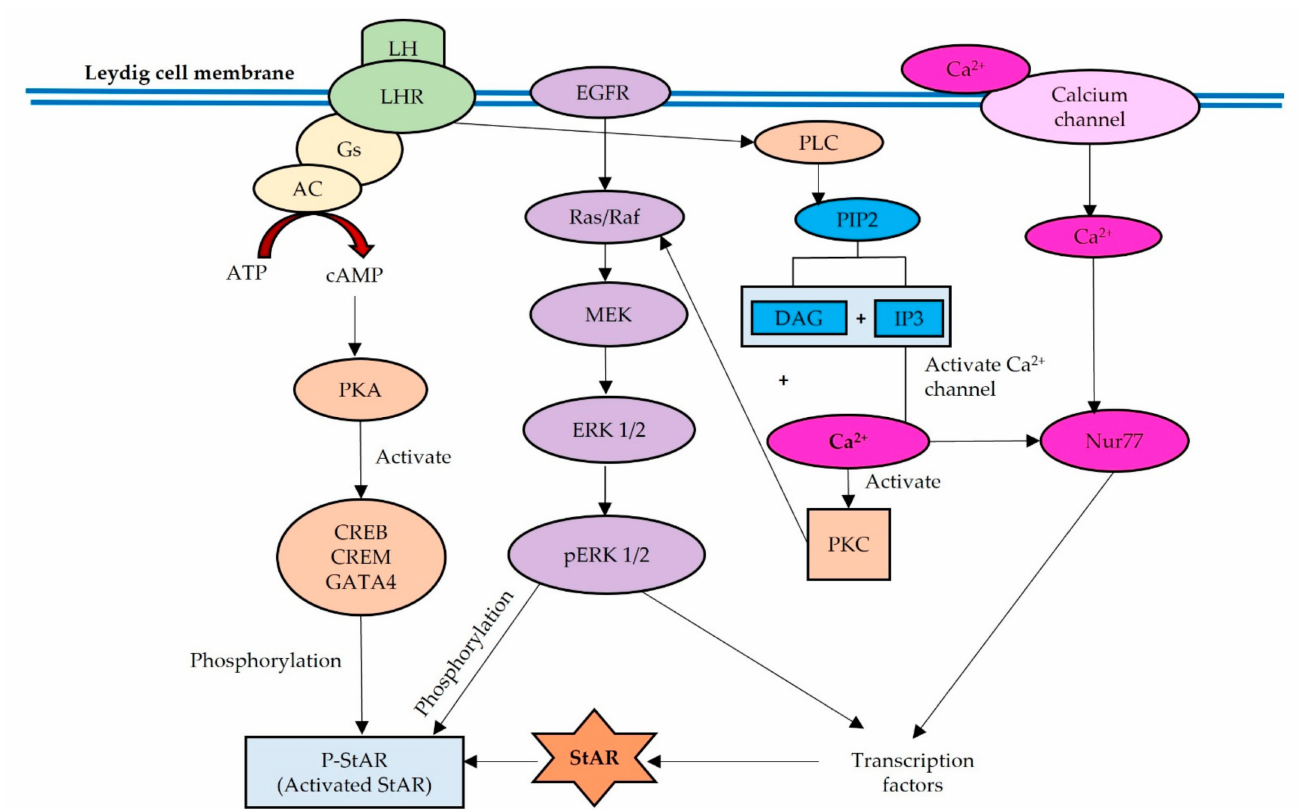
Figure 1. Three signaling pathways in regulating StAR expression: cAMP-PKA and PLC-PKC, EGFR-MAPK/ERK, and Ca 2+